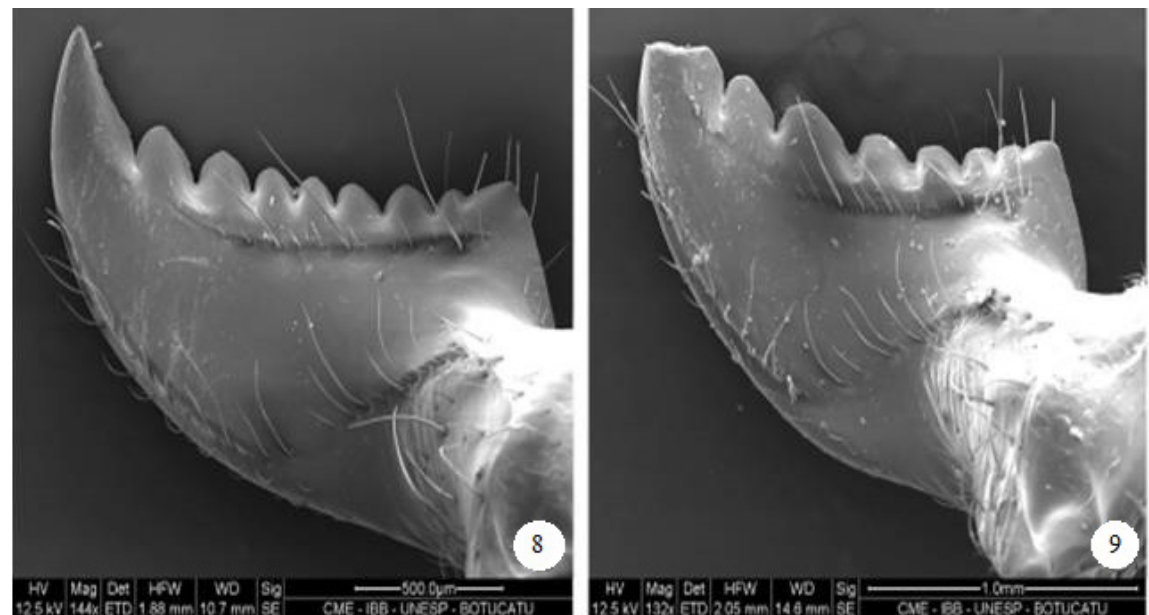
Figs 8-9 . ventral side of right mandibles of Atta bisphaerica (8) and Atta sexdens rubropilosa (9)